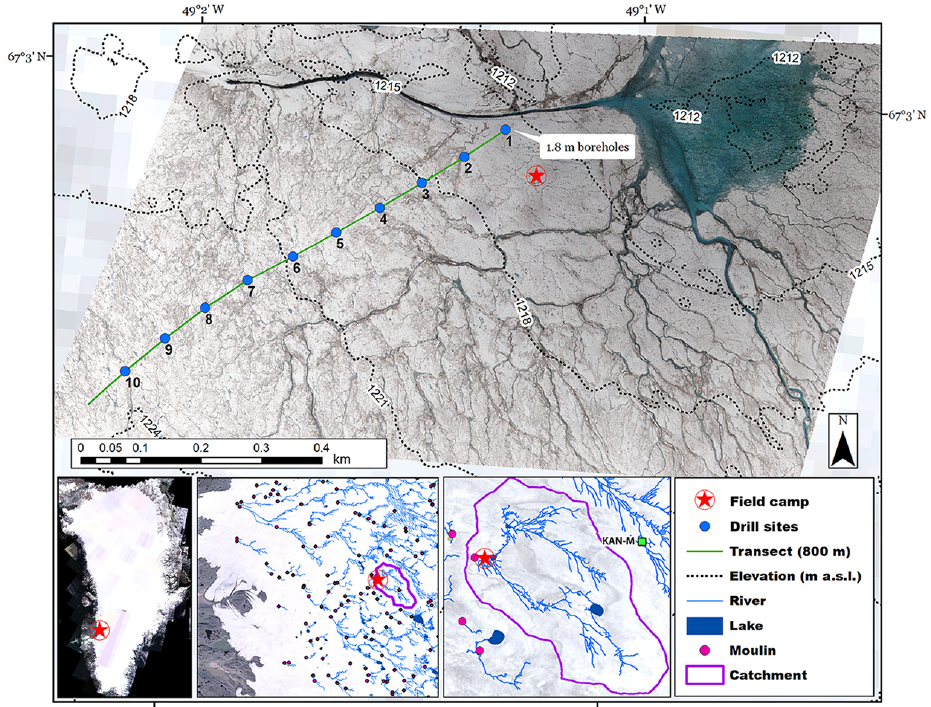
Figure 2. Ortho-rectified image mosaic of the study area at 6 cm ground resolution from RGB camera imagery collected 10 July 2016 on board a quadcopter drone. Background 30m Landsat image collected same day. Shallow ice cores extracted at 80m intervals (blue circles) along the 800m transect provide ice density measurements to depths of 1.1m, with two additional shallow ice cores extracted to 1.8m depth at interval 1. Insets (below) show the 63.1km 2 supraglacial catchment extent (magenta outline), as delineated from WorldView satellite stereo-photogrammetric digital elevation model topography, and supraglacial river and moulin locations derived from Landsat 8 imagery (Yang and Smith,